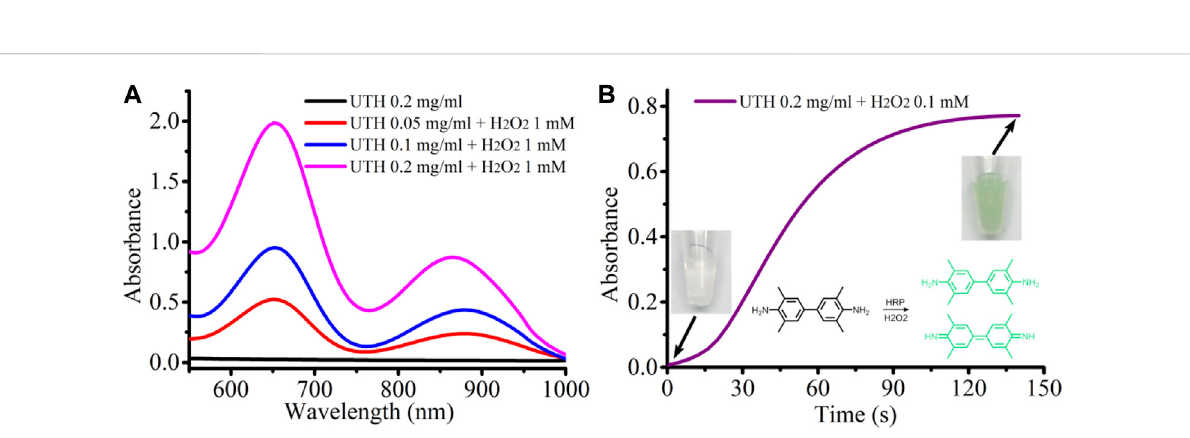
FIGURE 2 (A) Absorption spectra of the UTH before and after incubation with H 2 O 2 . (B) Change of the absorption value at 650 nm with time in the UTH –